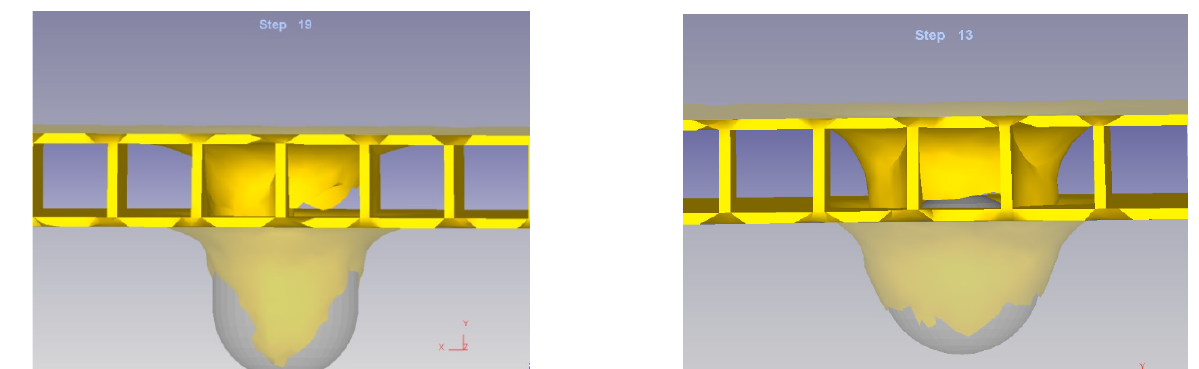
Figure 12 . Deformations of the structure in the two considered cases . Figure 12. Deformations of the structure in the two considered cases.